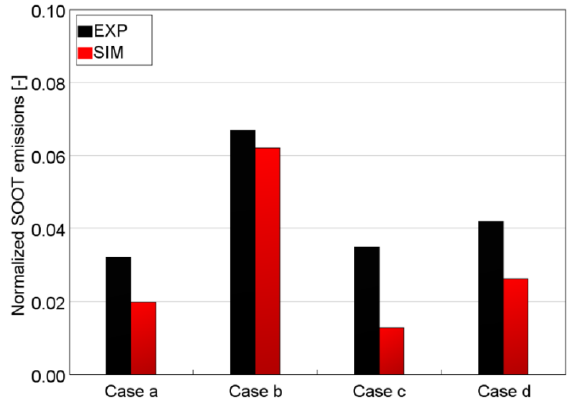
Figure 17. Normalized soot emissions for the injection schedules reported in Figure 14, experimental data (black) and simulated (red), WP: 1500 rpm × 5.0 bar BMEP.